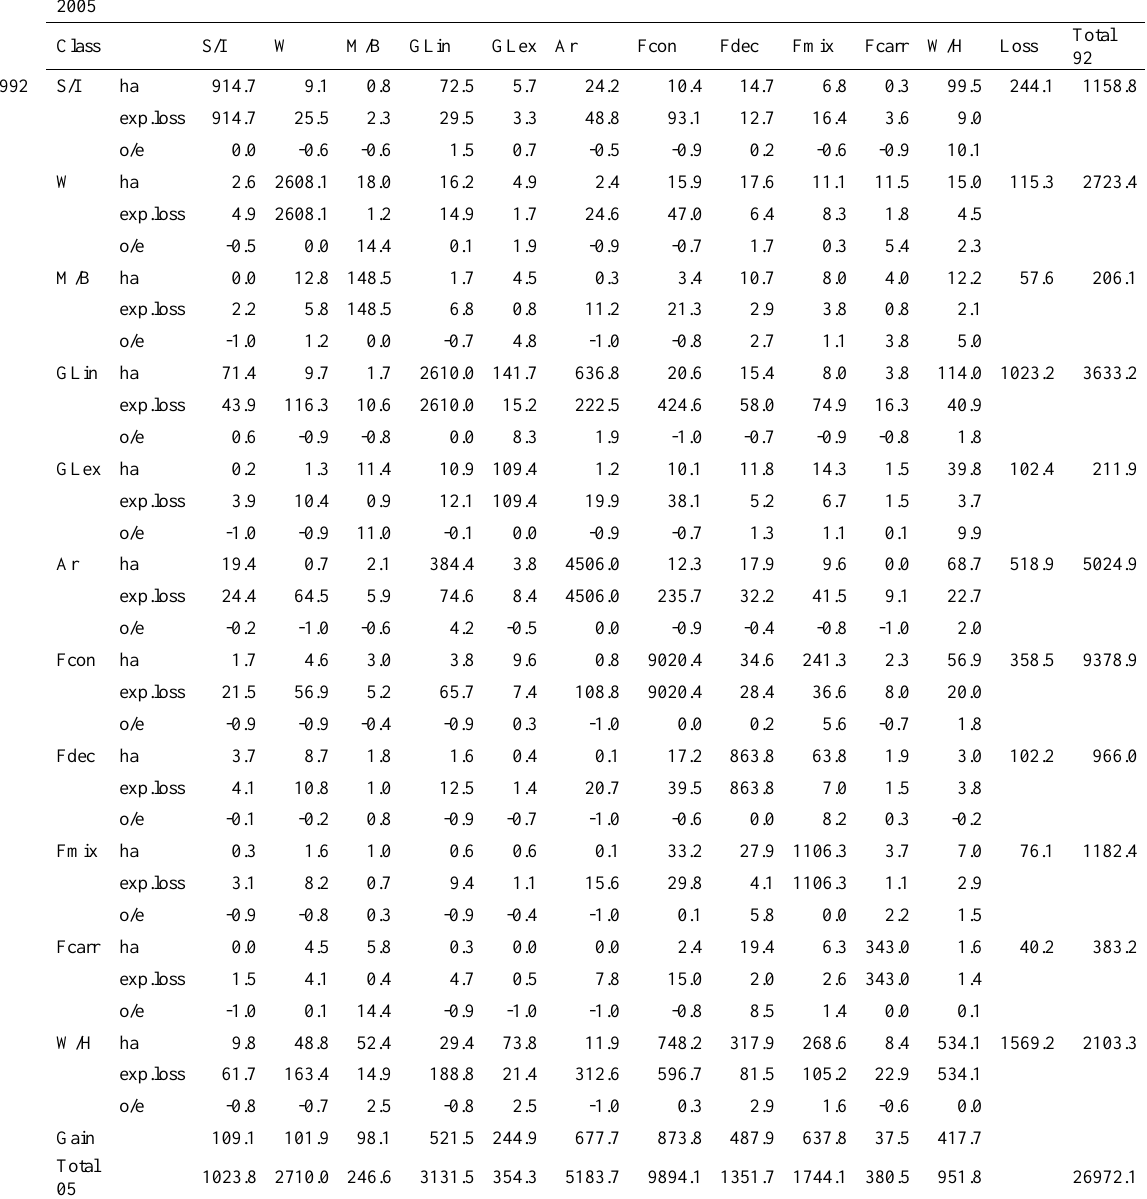
Table A1.2: Total